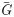
Results of the application of Virtual Twins with outcome time management.The ellipses in the figure represent the internal nodes containing the split variables, with below each ellipsis the corresponding split point. The upper ellipsis represents the root node corresponding to the complete group of children. The rectangles represent the leaves of the tree, that is, the final subgroups of children; each rectangle contains the sample size of the corresponding subgroup (N), and the mean estimated individual differential treatment effect (G¯). The leaves in which the estimated individual differential treatment effect exceeds the threshold c = 8.18) are represented by solid rectangles. It should be noted that after post-processing of the results, it appears that there is insufficient evidence that the subgroups in these leaves have a significantly better outcome on time management skills compared to the total group of children. Subgroup estimated treatment effect was 8.07 (d = 0.56). Total group estimated treatment effect was 6.99 (d = 0.48).